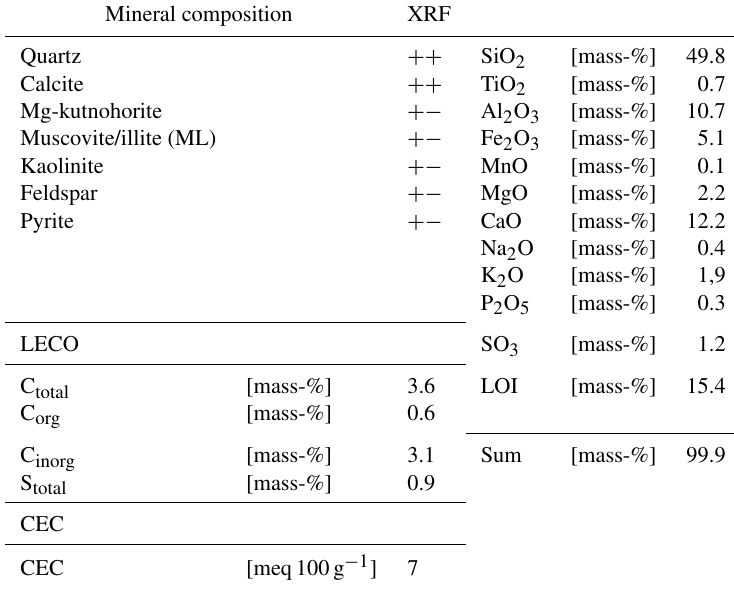
Table A1. Geochemical and mineralogical composition of the bulk